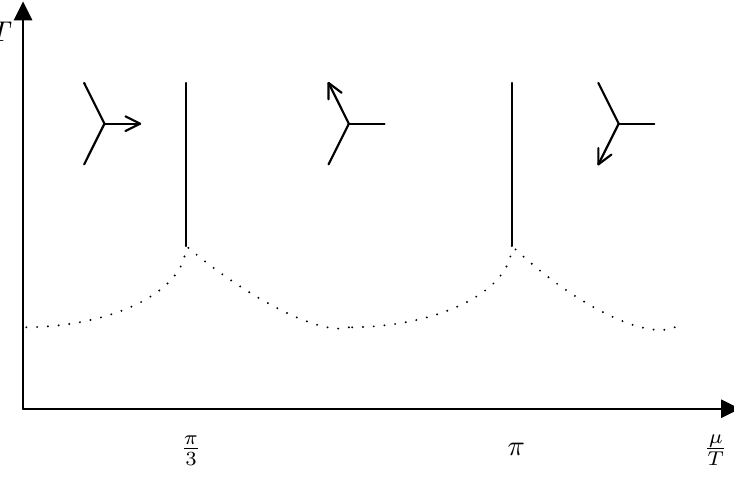
Figure 1 . A Sketch of the phase diagram of R-W